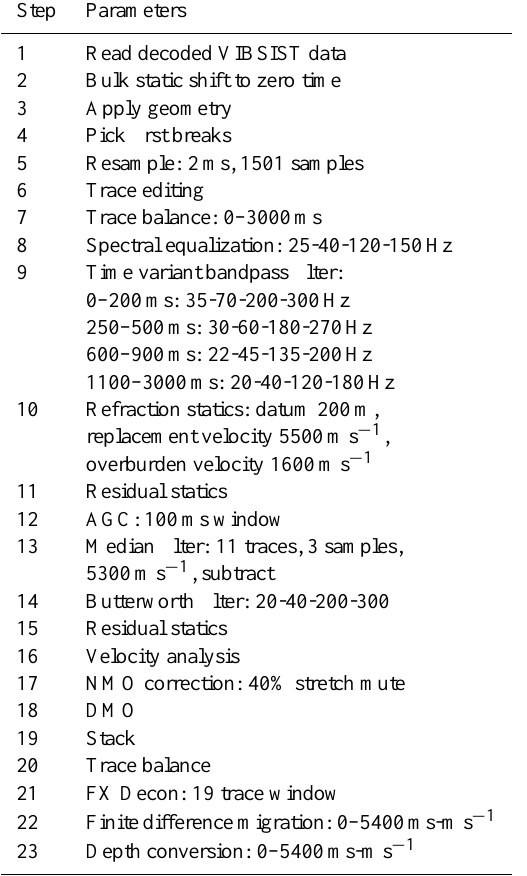
Table 2. Processing steps for the reflection seismic experiment.